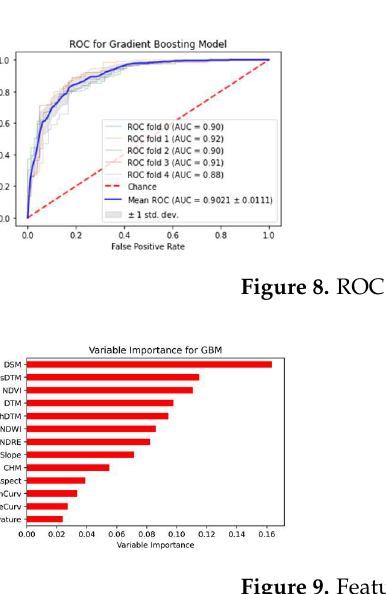
Figure 7. Performance metrics (Sensitivity, Specificity, Accuracy, and AUC scores) for three Gradient Boosting models on pooled data.